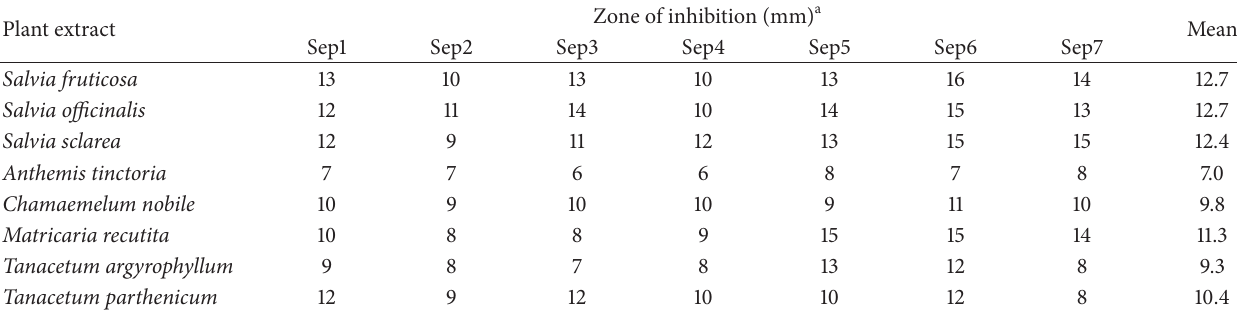
Table 1: Inhibition zone diameter in mm as established by disc diffusion method.